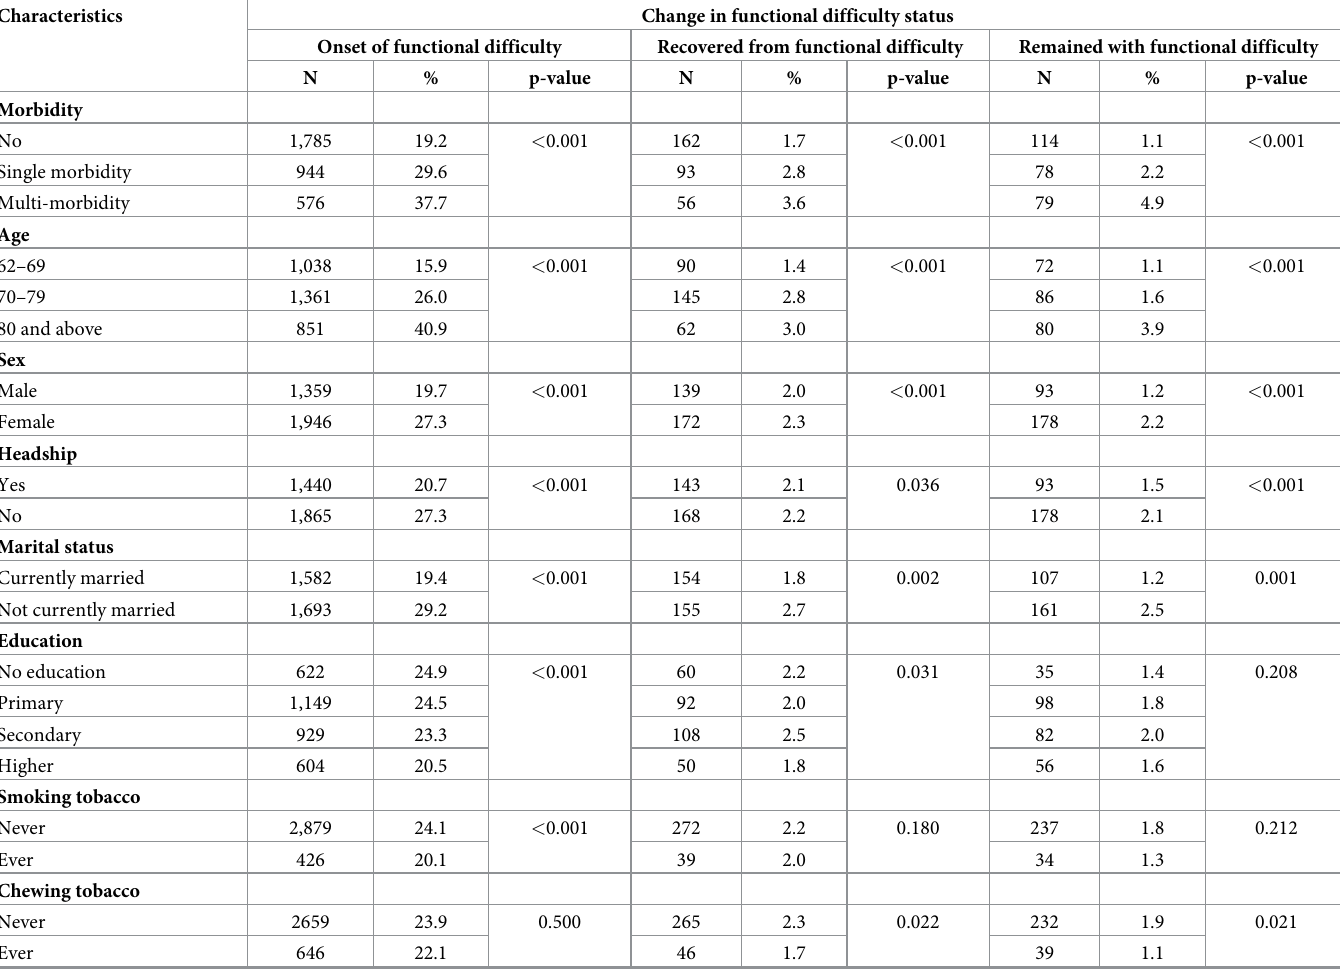
Table 2. Prevalence of onset, recovery from and remaining with functional difficulty among older adults by background characteristics.